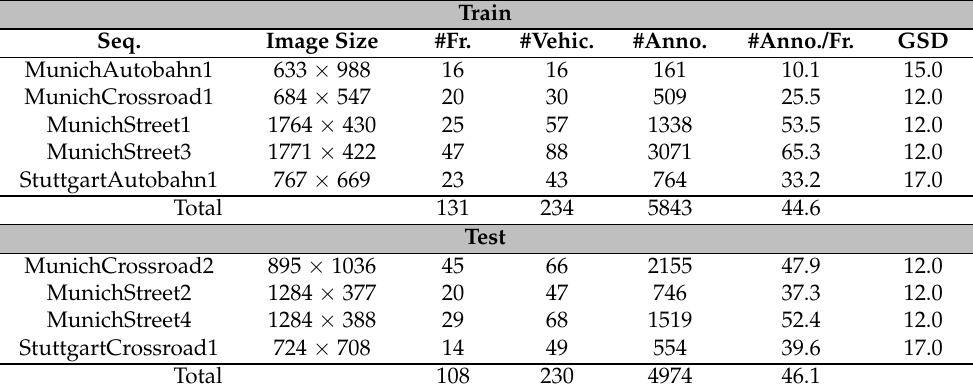
Table 2. Statistics of the KIT AIS vehicle